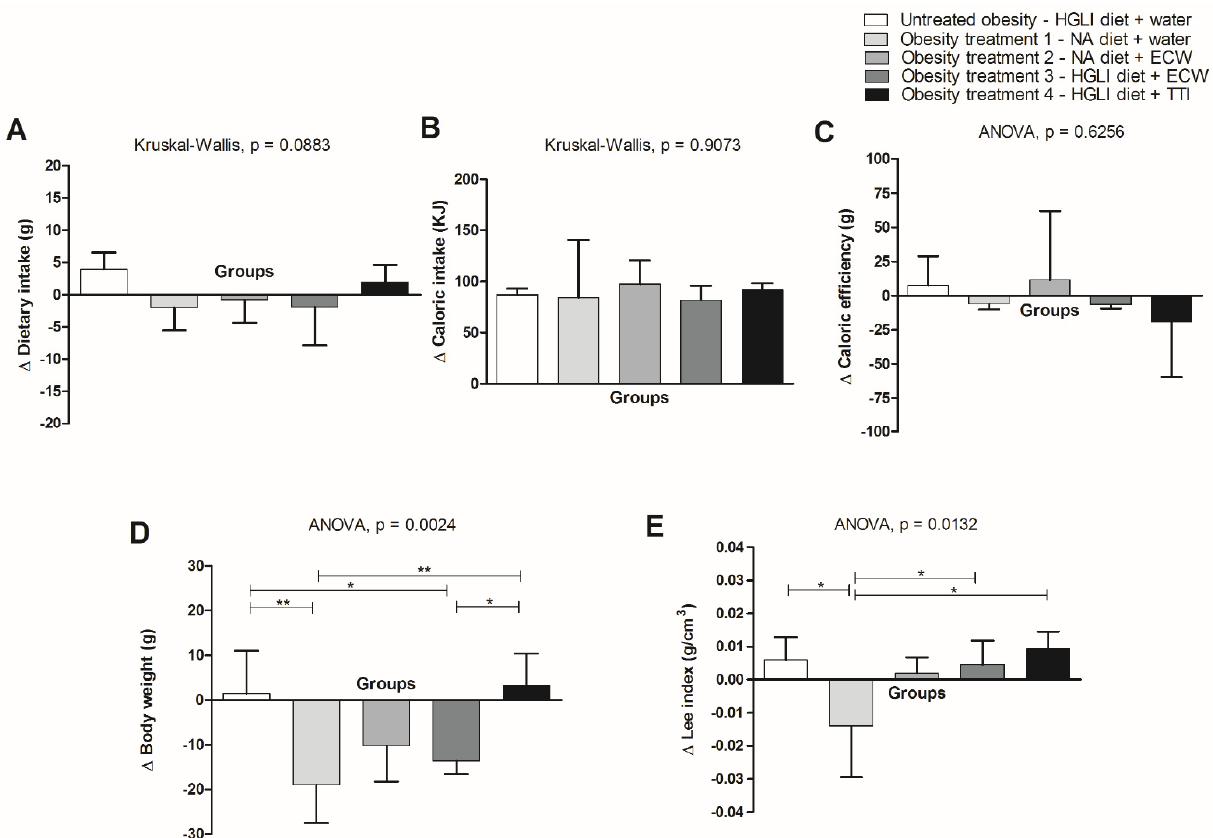
Figure 3. Variation in dietary intake, caloric intake, caloric efficiency, body weight, and nutritional status of Wistar rats with obesity induced by HGLI diet, submitted for ten days to different treat-